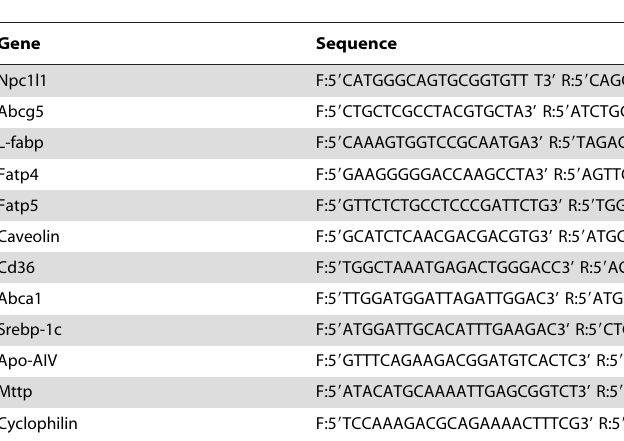
Table 1. Primers used for quantitative real time PCR.